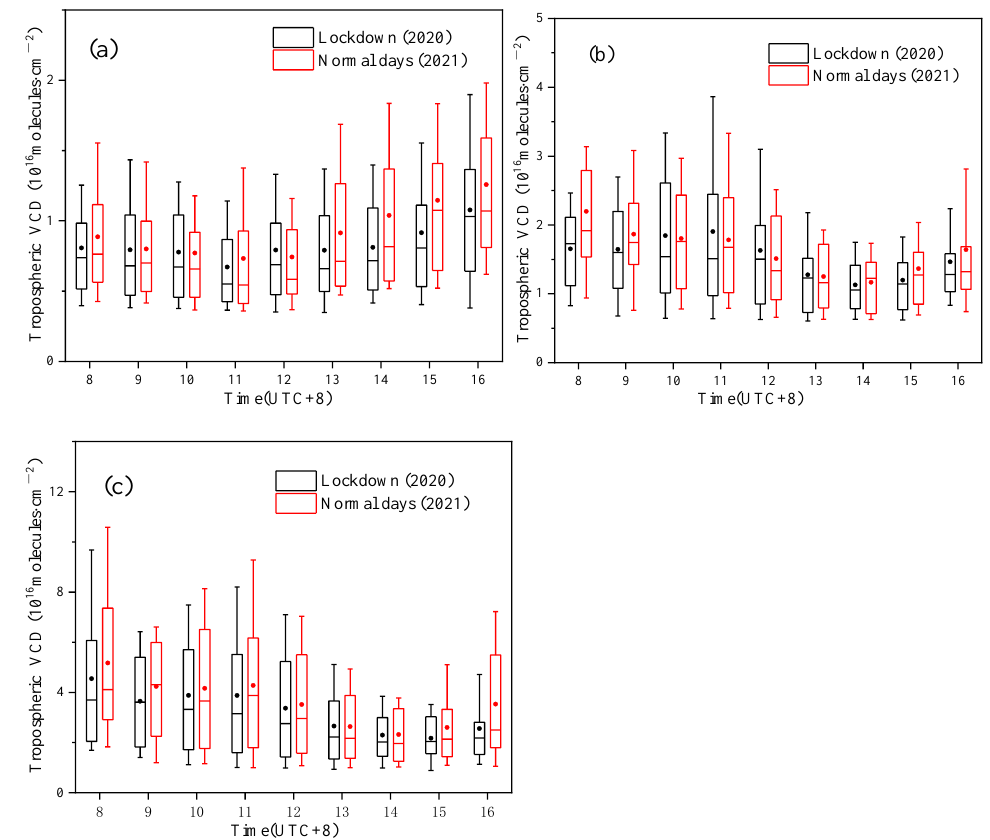
Figure 6. Averaged diurnal variations of ( a ) NO 2 , ( b ) HCHO and ( c ) SO 2 VCDs observed over Huaibei during the lockdown period and normal days.